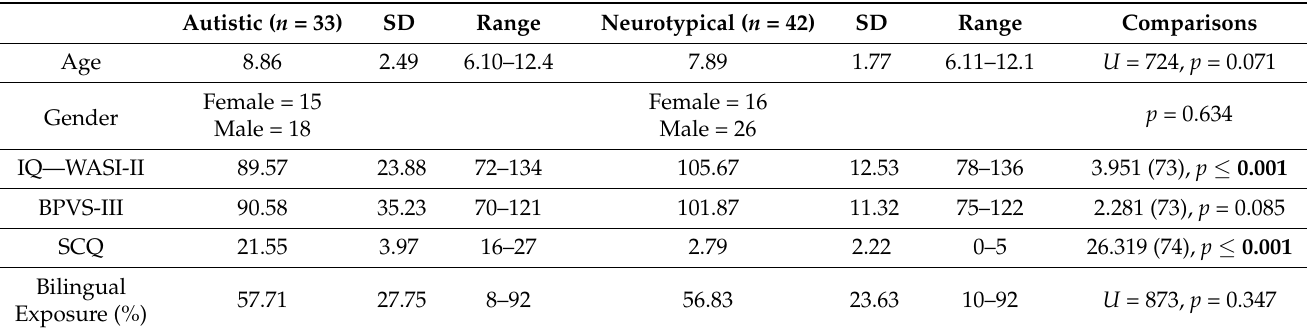
Table 1. Descriptive statistics (Mean (Standard Deviation)) for demographics. Bold comparisons indicate significance